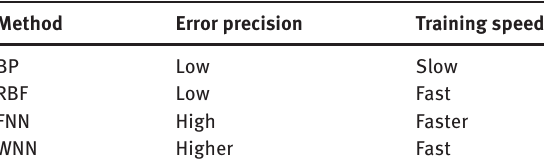
Table 2. Comparison of the Proposed Approach with Classic